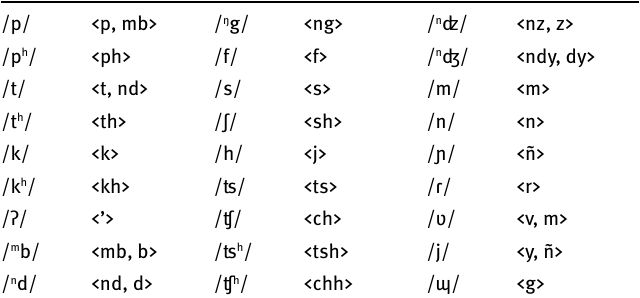
Table 3. Consonants – orthography